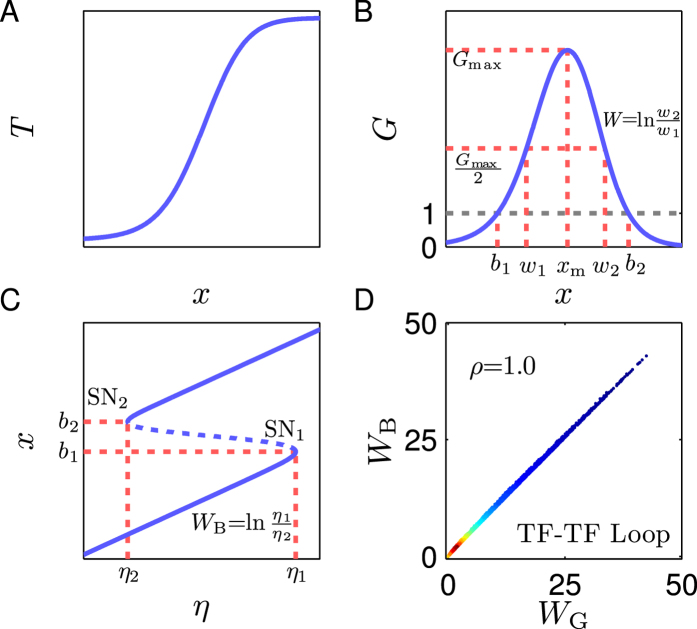
Characteristics of individual PFLs in terms of gain.(A) Transfer function T is characterized by a sigmoid function. (B) Logarithmic gain G. If Gmax > 1, G equals 1 at b1 and b2. (C) Bifurcation diagram. Two SN bifurcations (marked by SN1 and SN2) appear at η1 and η2. (D) Scatter diagram of WB versus WG. Each dot represents one TF-TF loop. From blue to red, more dots are distributed locally. All axes except the G-axis are in log scale in (A–C).